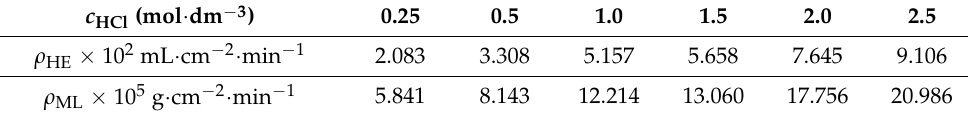
Table 1. Corrosion rates for mild steel samples at different concentrations of HCl solutions at 25 ◦